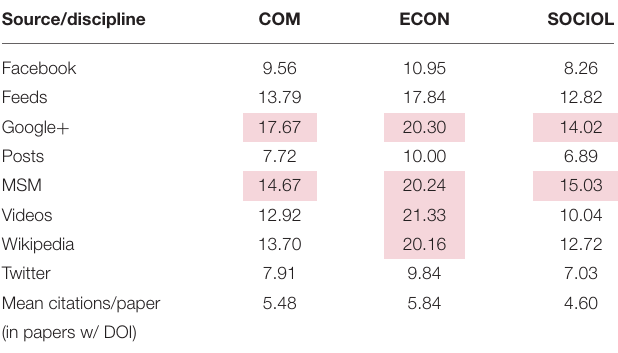
TABLE 7 | Impact (citations/paper) of papers mentioned in the social media by type of source and discipline.